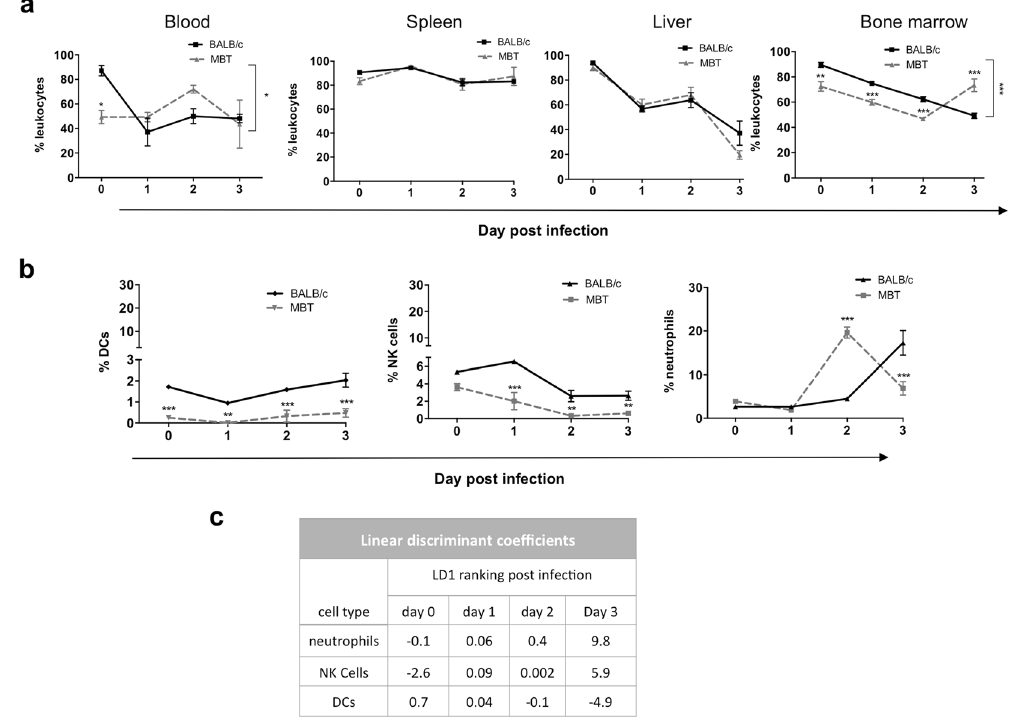
Figure 4. Changes in the percentages of innate immune cells in RVFV-infected BALB/c and MBT mice. (a ) A comprehensive flow cytometric profiling of leukocytes defined as positive for CD45 in the blood, spleen, liver and bone marrow of RVFV-infected BALB/c and MBT mice on days 0–3 post infection. ( b ) Percentages of key innate immune cell populations, DCs (CD45 + , CD11c + ), natural killer (NK) cells (CD45 + , CD335 + ), and neutrophils (CD45 + , Ly6C/Ly6G + ), after infection with RVFV in the spleen of BALB/c and MBT mice. (c) Linear discriminant (LDA) analyses ranks neutrophils, as having the greatest impact on the dissimilarity between BALB/c and MBT spleen at day 3 post infection. Cytometry experiments were performed twice for each time point (n = 5 mice/strain/timepoint). Representative experiments are displayed. Data are represented as mean ± SEM. Two-way ANOVA was used to test differences between means. * P values < 0.05, ** P < 0.01, and *** P <